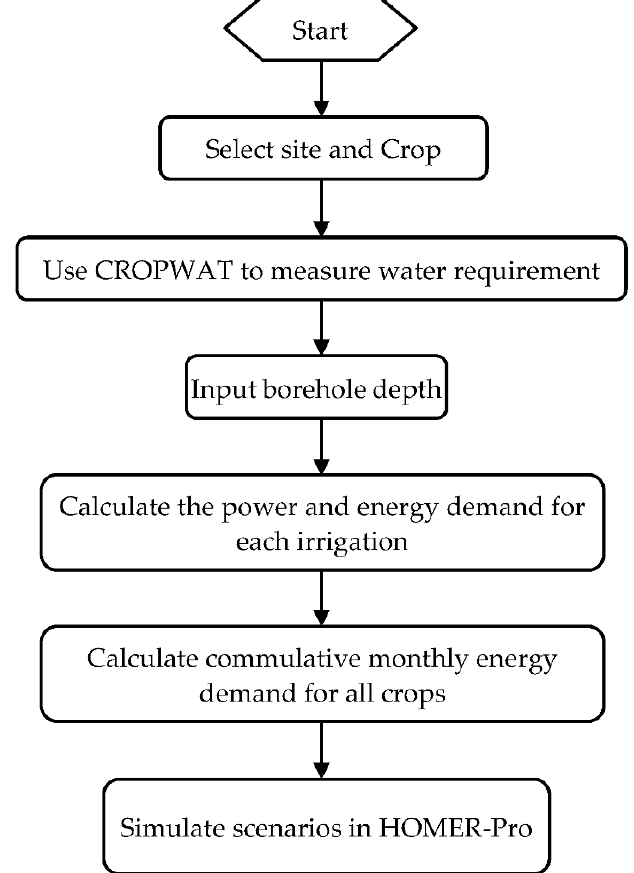
Figure 3. Approach for the design of a hybrid RE system for agriculture.